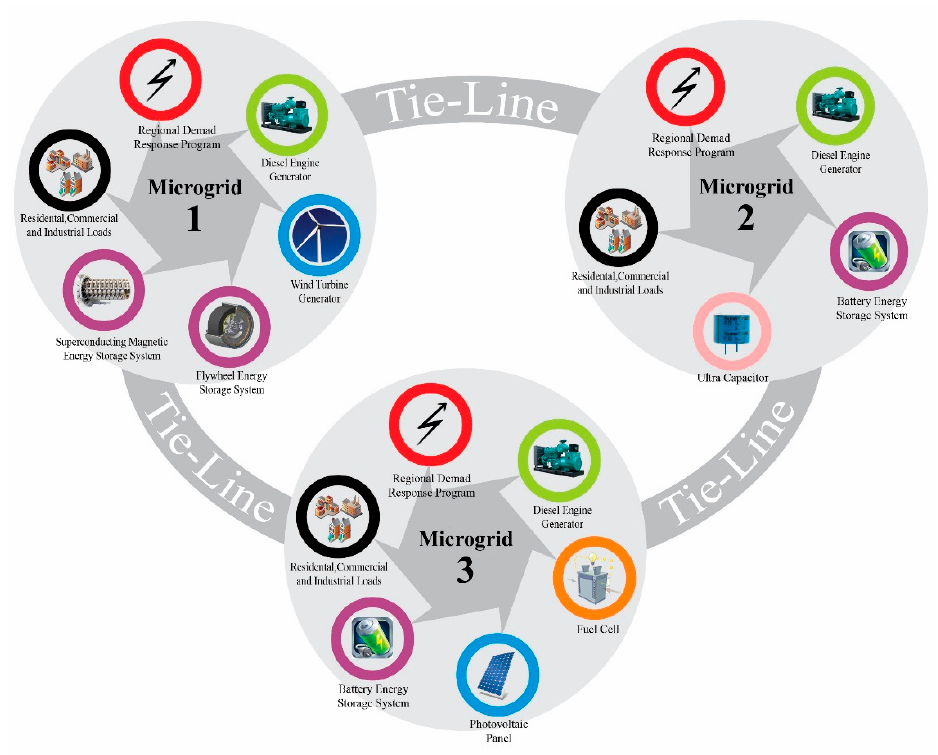
Figure 1. Studied multiple microgrid clusters.